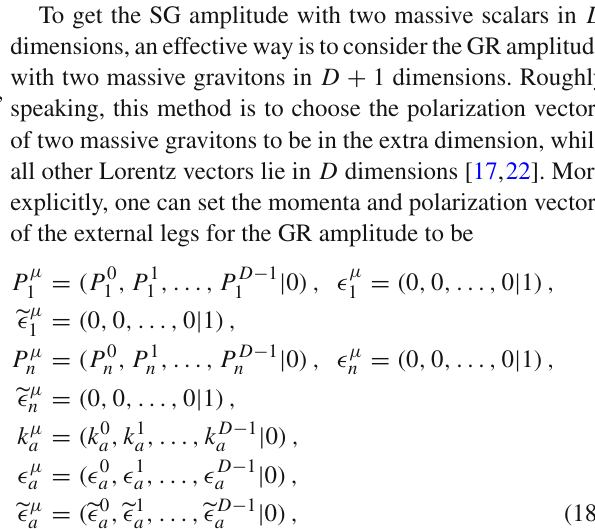
ditions, (1) α 0 ⊂ { 1 , . . . , n } , (2) α 0